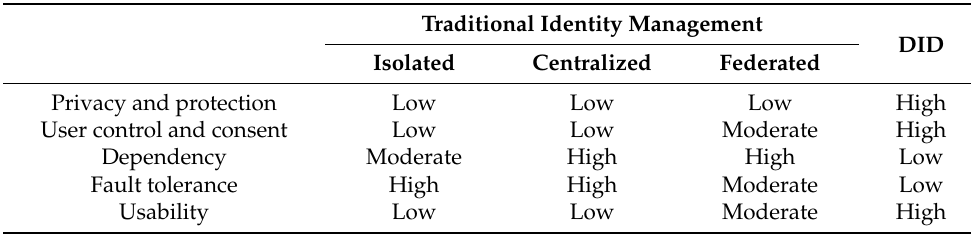
Table 1. Comparison of traditional identity managements and DID. Traditional Identity